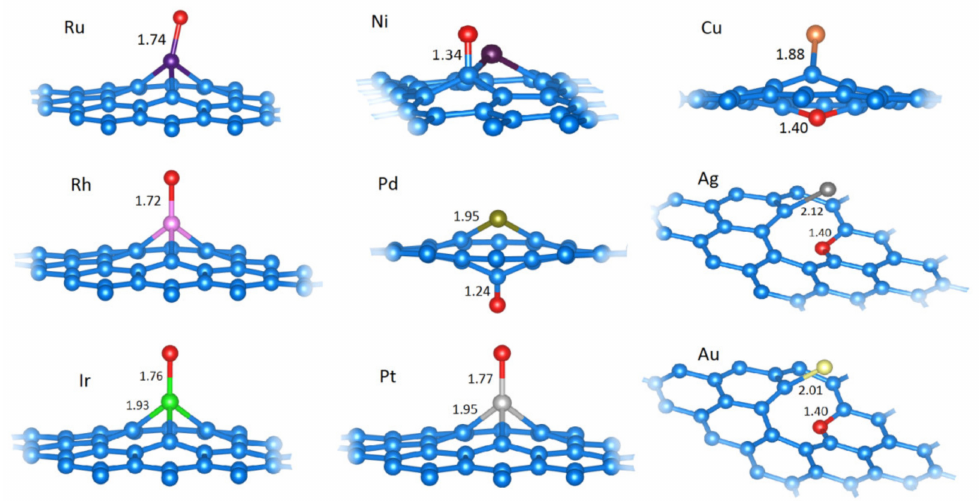
Figure 6. The relaxed structures of O at the most favorable positions on C 31 M systems (M is labeled for each structure). M − O or C − O (depending on O position) and C − M bond lengths are given in Å (if all C − M bonds are of equal length, only one such length is indicated). Structural models were made using VESTA